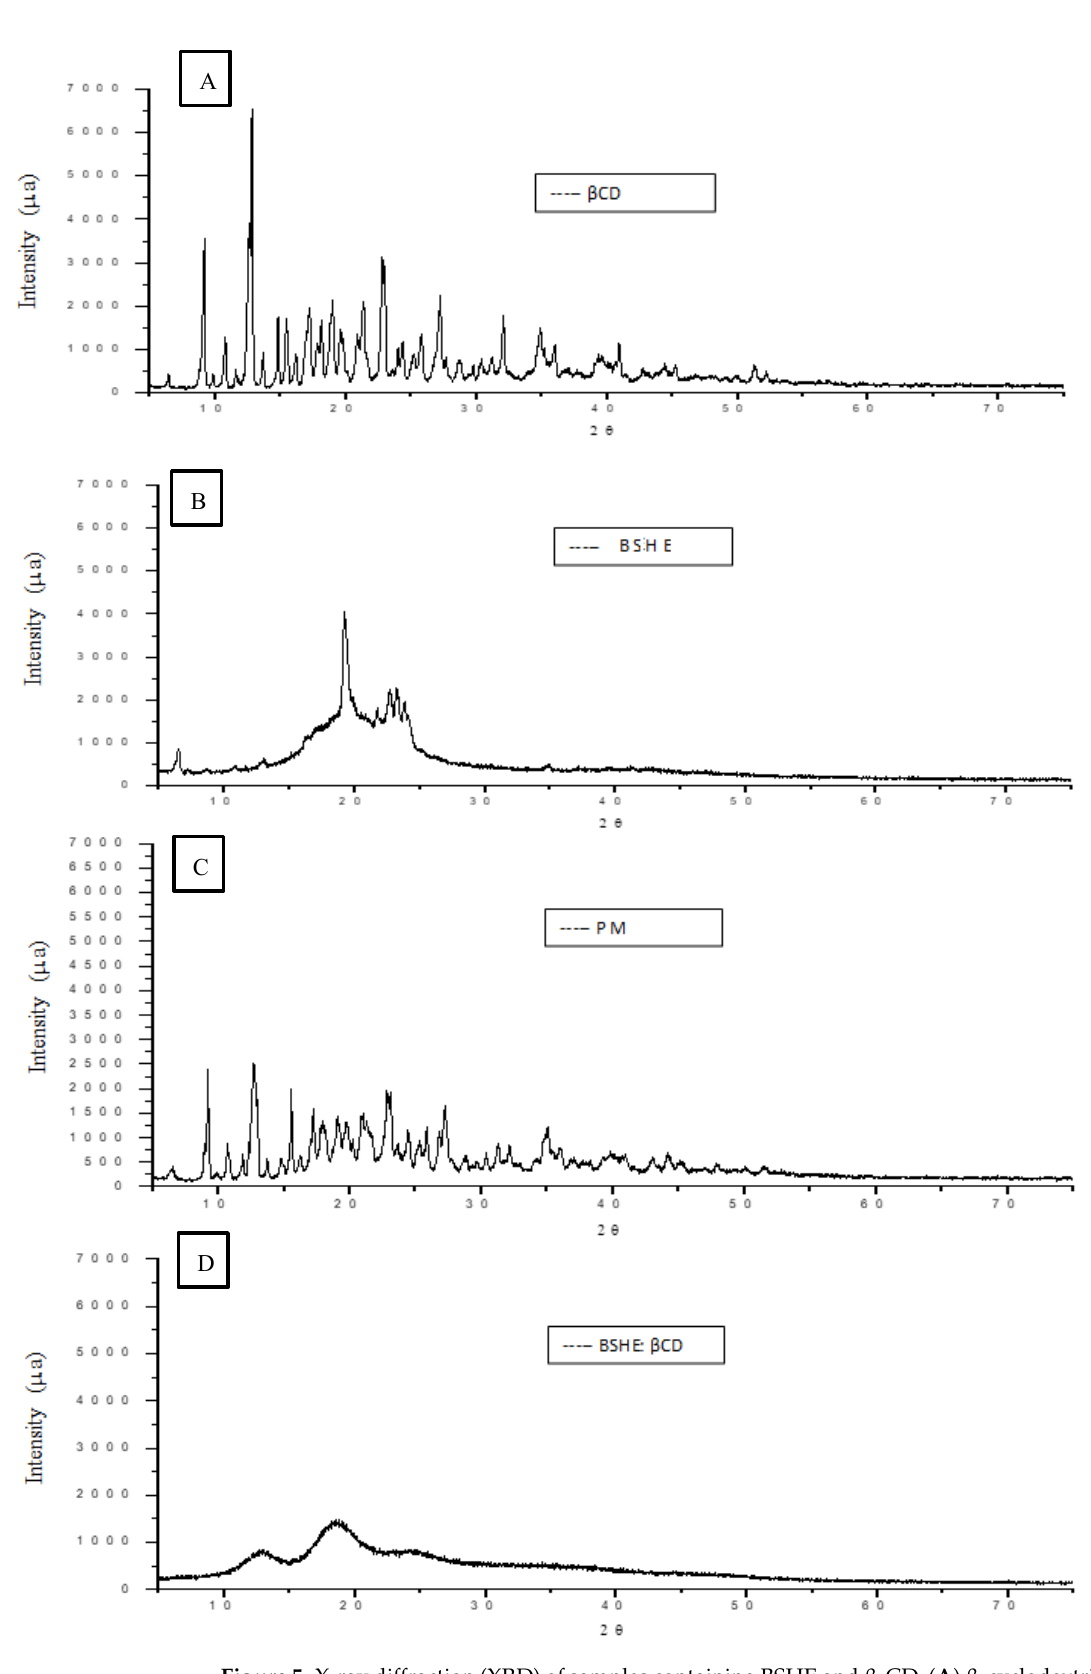
Figure 5. X-ray diffraction (XRD) of samples containing BSHE and β -CD. ( A ) β -cyclodextrin molecule, ( B ) bacuri seed hexane extract (BSHE), ( C ) physical mixture between BSHE: β -CD, and ( D ) BSHE: β -CD inclusion complexes.